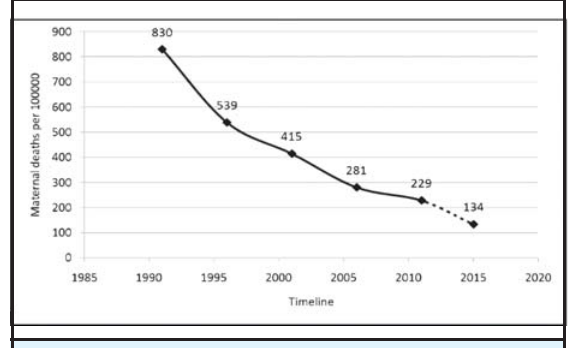
Figure 1. Trend of maternal mortality in Nepal, 1990-